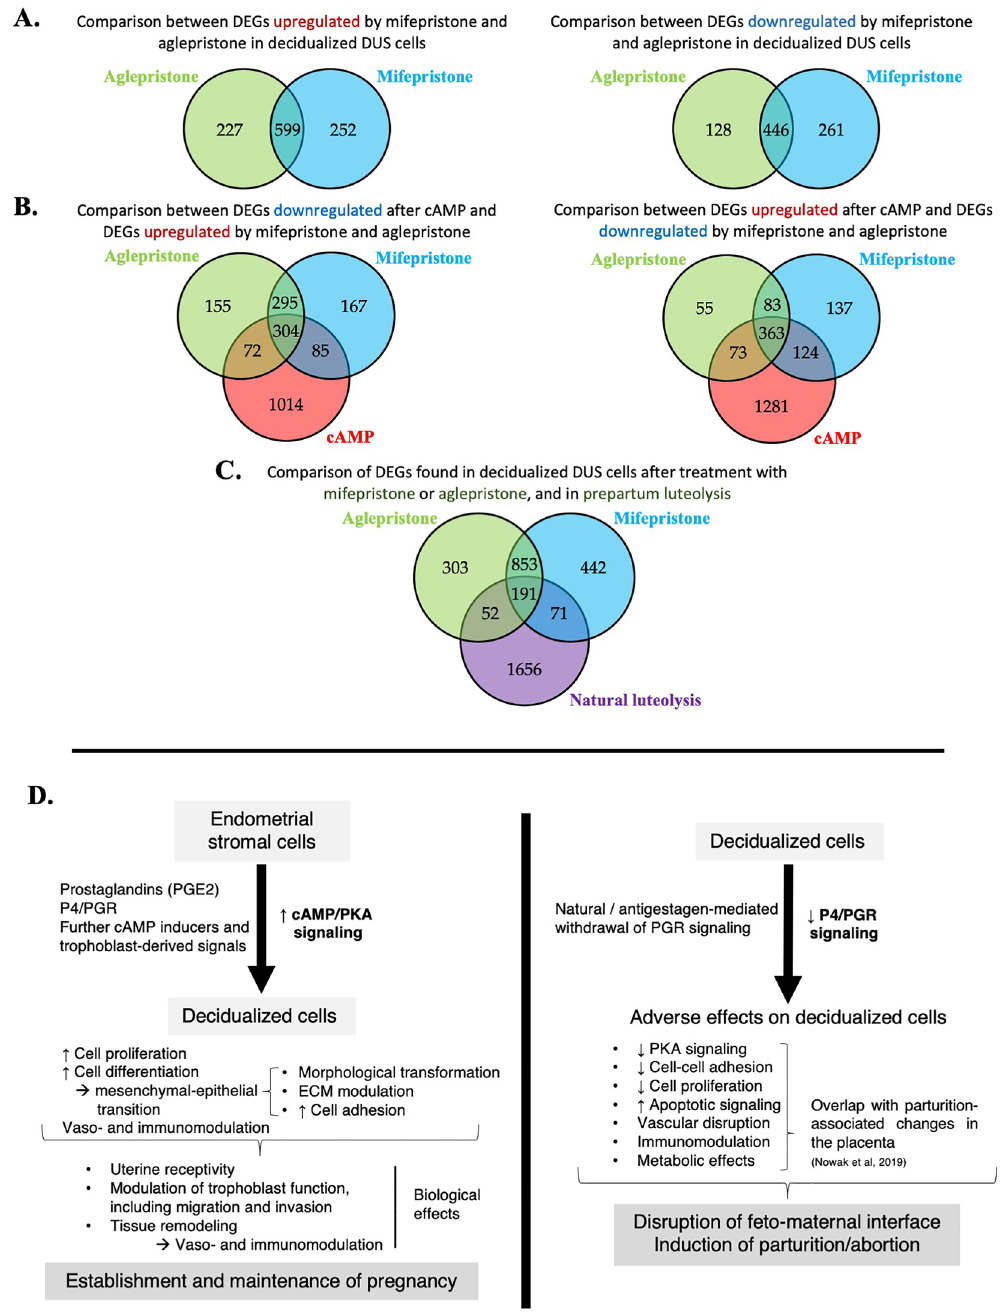
Figure 6. Venn diagrams showing the distribution and overlap of DEGs between the different analyzed contrasts, and schematic representation of decidualization-associated changes in dog uterine stromal cells and antigestagen-induced effects in decidualized cells. ( A ) Intersection between list of DEGs from the contrasts “aglepristone versus cAMP” and “mifepristone versus cAMP”. ( B ) The intersection between DEGs downregulated in the contrast “cAMP versus control” and upregulated/downregulated in the contrasts “aglepristone versus cAMP” and “mifepristone versus cAMP”. ( C ) Intersection between the list of both up- and downregulated DEGs from “aglepristone versus cAMP” and “mifepristone versus cAMP”, and genes differentially expressed in the canine placenta at the time of prepartum luteolysis, when compared with mid- term stage [contrast “natural luteolysis versus mid-gestation”, P < 0.01, FDR < 0.1, presented in 21 ]. Lists of DEGs ( P < 0.01, FDR < 0.01, unless stated otherwise) from respective comparisons were used, with the complete list of genes from each intersection being provided in Supplementary File 3. ( D ) The main findings of the present work are summarized, taking into consideration previous descriptions 8,21–24 . A detailed explanation is provided in the